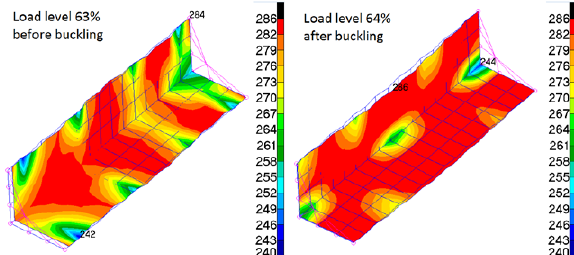
Figure 5. Graphic visualization of von Mises stress distribution on FE model with imperfection C